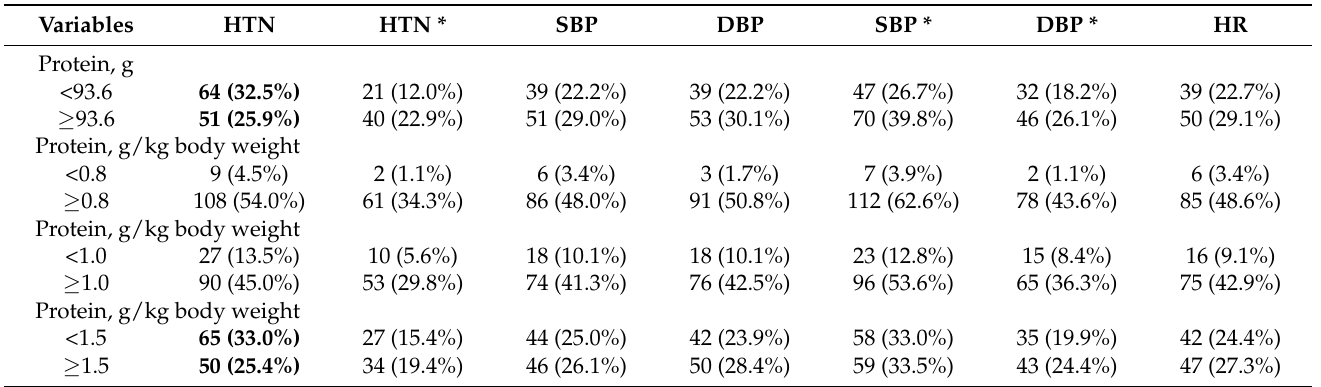
Table 4. Frequency (%) of the distribution of older adults in hypertension-related parameters.